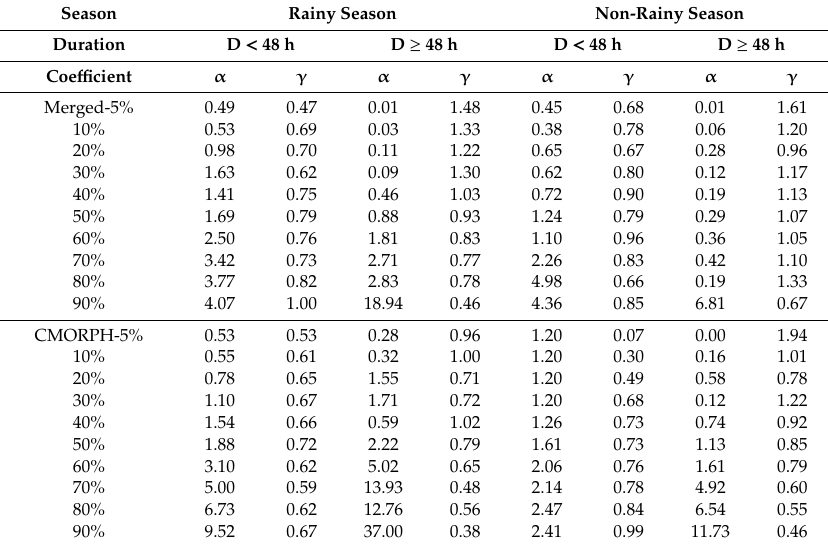
Table 2. Coe ffi cients of intercept α and slope γ at di ff erent levels of quantile regression lines obtained by combining precipitation and CMORPH precipitation.